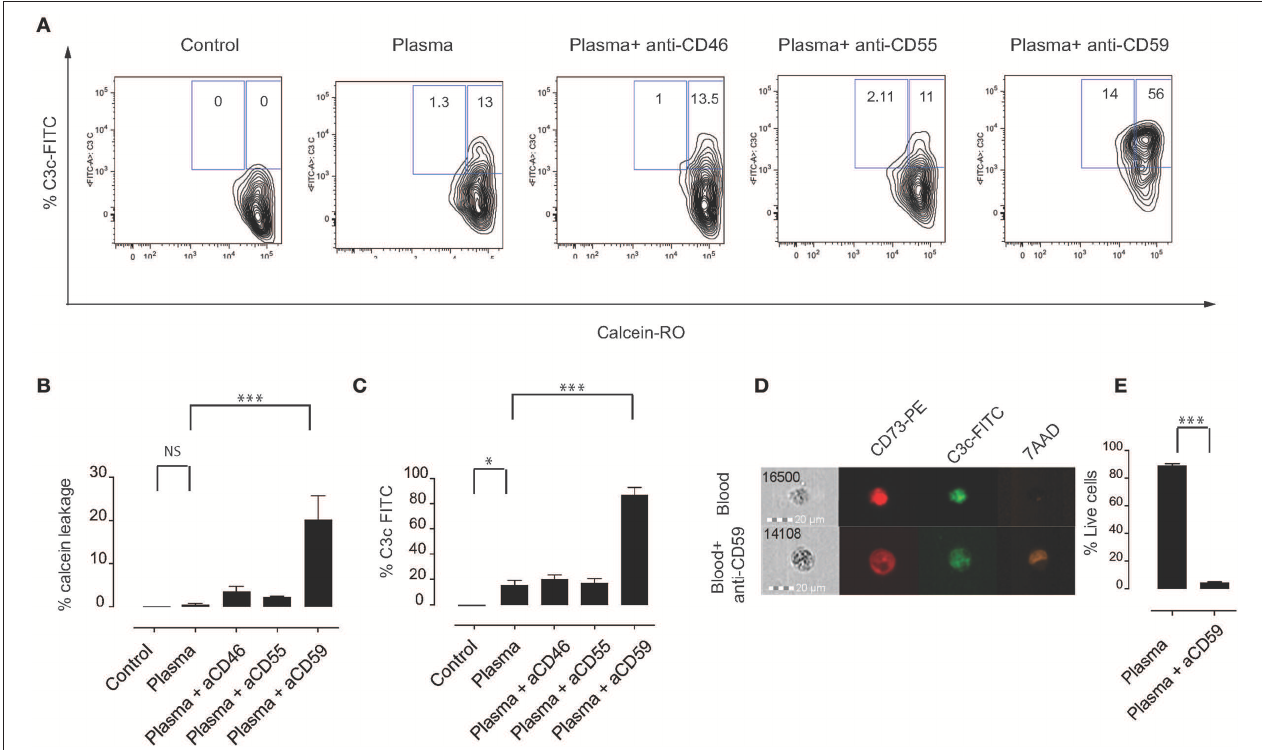
FIGURE 2 | Effects of blocking complement regulators on MSC pre-treated with plasma. (A) Representative contour plots of calcein RO-stained MSC exposed to plasma, HI plasma or medium for 1h in the presence or absence of blocking antibodies against complement inhibitors CD46, CD55, or CD59. (B) Percentage of calcein leakage, and (C) percentage of C3b/iC3b binding to MSC pre-treated with anti-CD46, anti-CD55, and anti-CD59 blocking antibodies in the presence of active plasma. Data shown are means and SD ( n = 4). (D) FlowSight images showing C3b/iC3b binding and 7-AAD (death marker) on MSC in the presence or absence of anti-CD59 blocking antibody in the blood chamber experiments. (E) Percentage of live cells (aqua live dead negative) of MSC pre-treated with plasma in the presence or absence of anti-CD59 blocking antibodies. Data shown are means and SD ( n = 4). Data are representative of two independent experiments. Statistical significance was determined using paired t -test * p = 0.05 and *** p =